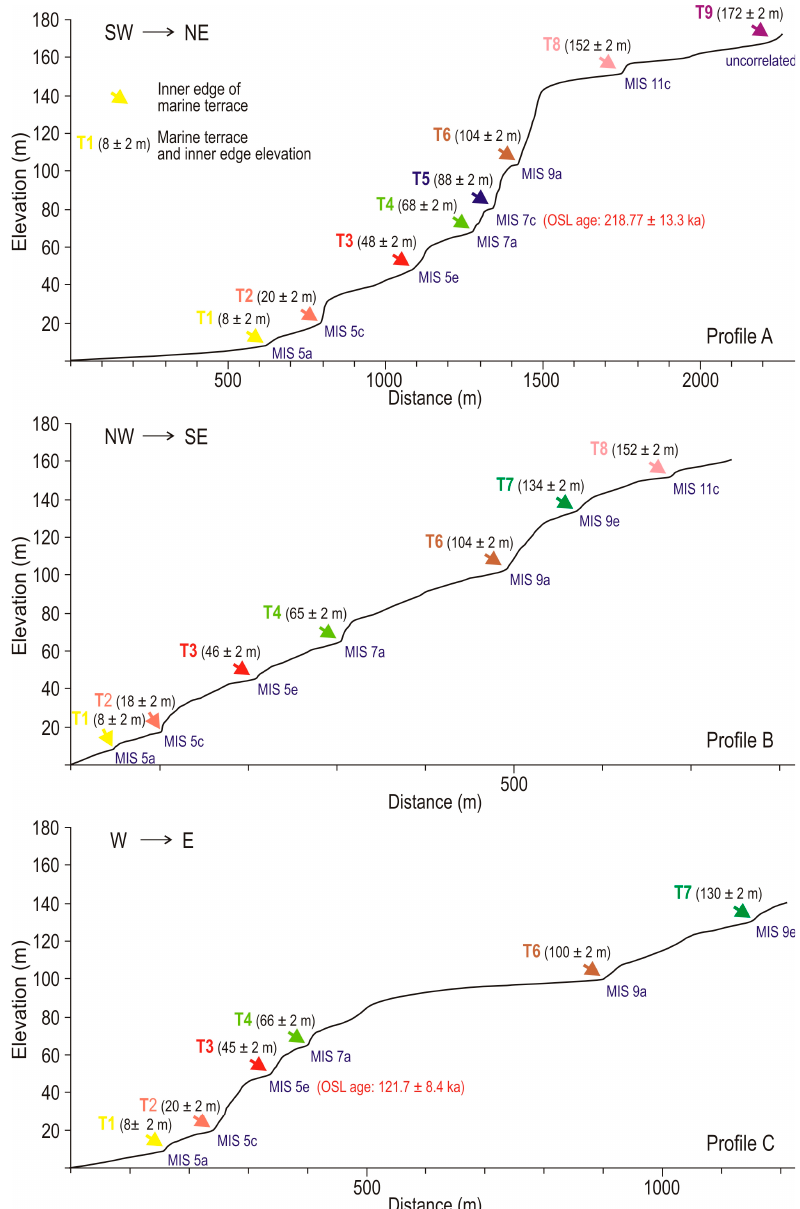
Figure 6. Three topographic profiles constructed 2.3 km northwest of Cape Punta (Profile A), at the western part of the Elafonissos Island (Profile B), and 4.6 km south of Neapolis (Profile C). For locations of the profiles, see map in Figure 4. The marine terraces are numbered consecutively, starting with the lowest one. The elevations of the inner edges for the terraces, as derived from the topographic profiles, are provided. The location and the age of the OSL samples, as well as the MIS attributed to each marine terrace, are also